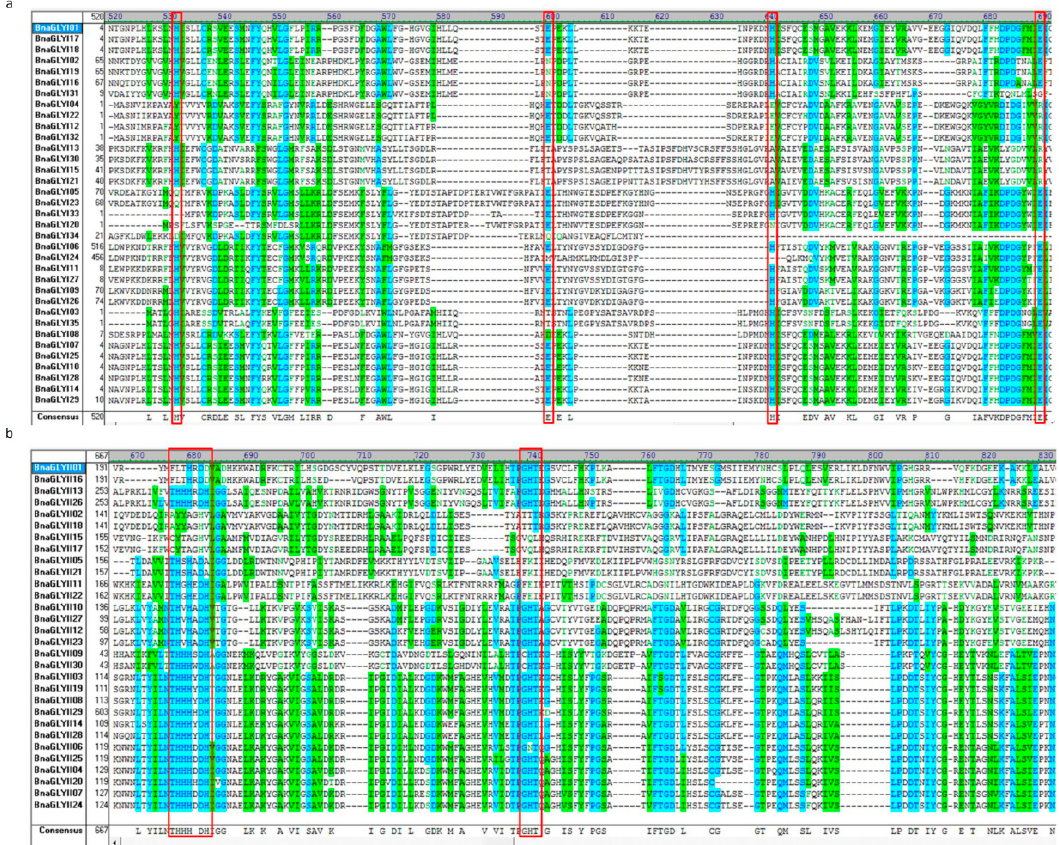
Figure 4. Multiple sequence alignment of GLY domain of all BnaGLYI and BnaGLYII proteins. ( a ) The conserved amino acids (H/QEH/QE) of BnaGLYI were marked by red boxes. ( b ) The red boxes indicate the most conserved metal binding motif (THHHXDH) and active site motif (G/CHT) of BnaGLYII proteins.